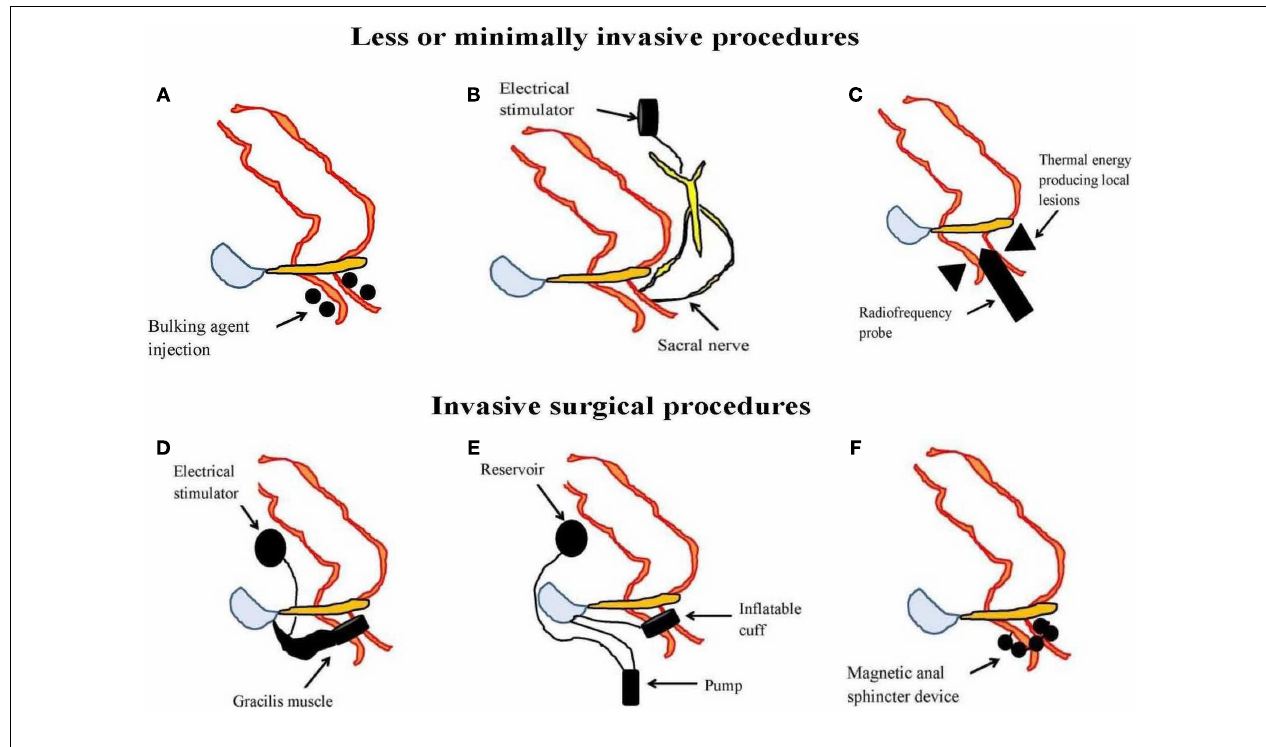
FIGURE 3 |An illustration of less or minimally invasive procedures [(A) injectable bulking agent, (B) sacral nerve stimulation, and (C) radiofrequency anal sphincter remodeling or SECCA procedure]